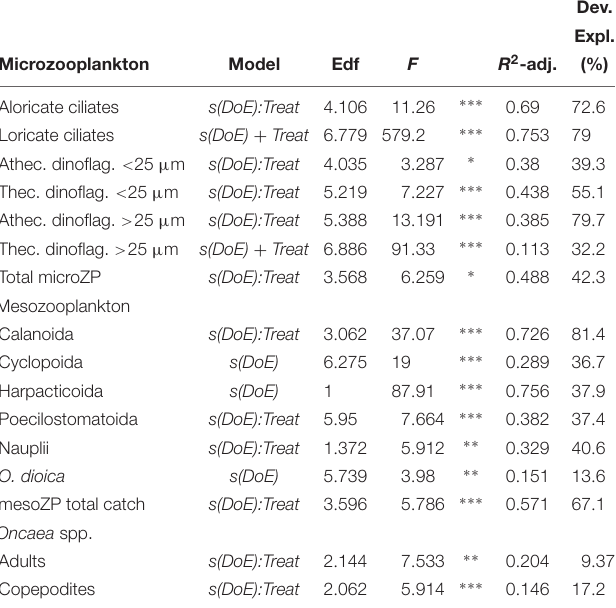
TABLE 2 | Zooplankton GAMM analyses.